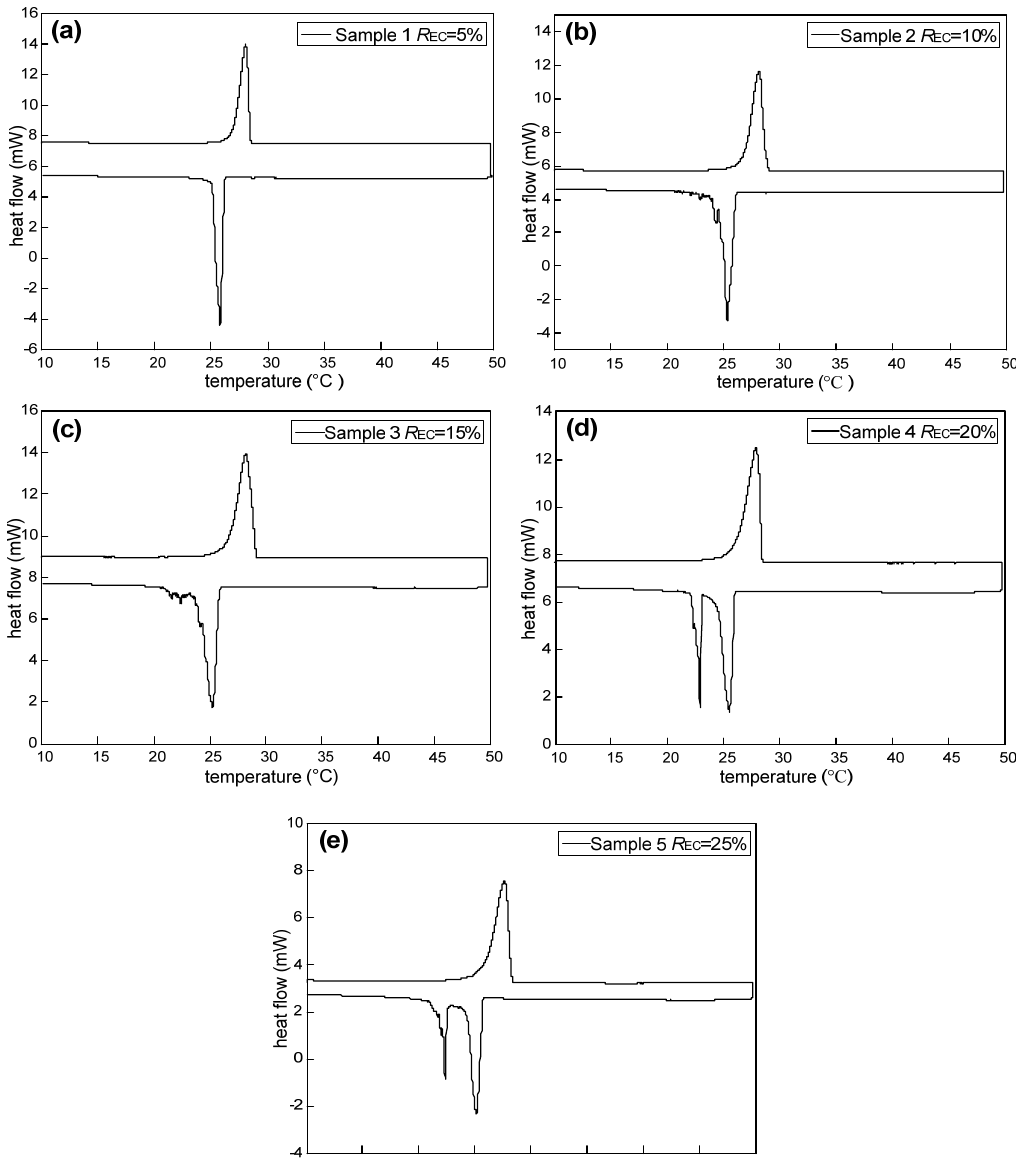
Figure 8. DSC (differential scanning calorimeter) thermograms of the M-NEPCMs prepared with different amounts of emulsifier. Table 6. Thermal properties of M ‐ NEPCMs prepared by using different amounts of emulsifier. Sample No.